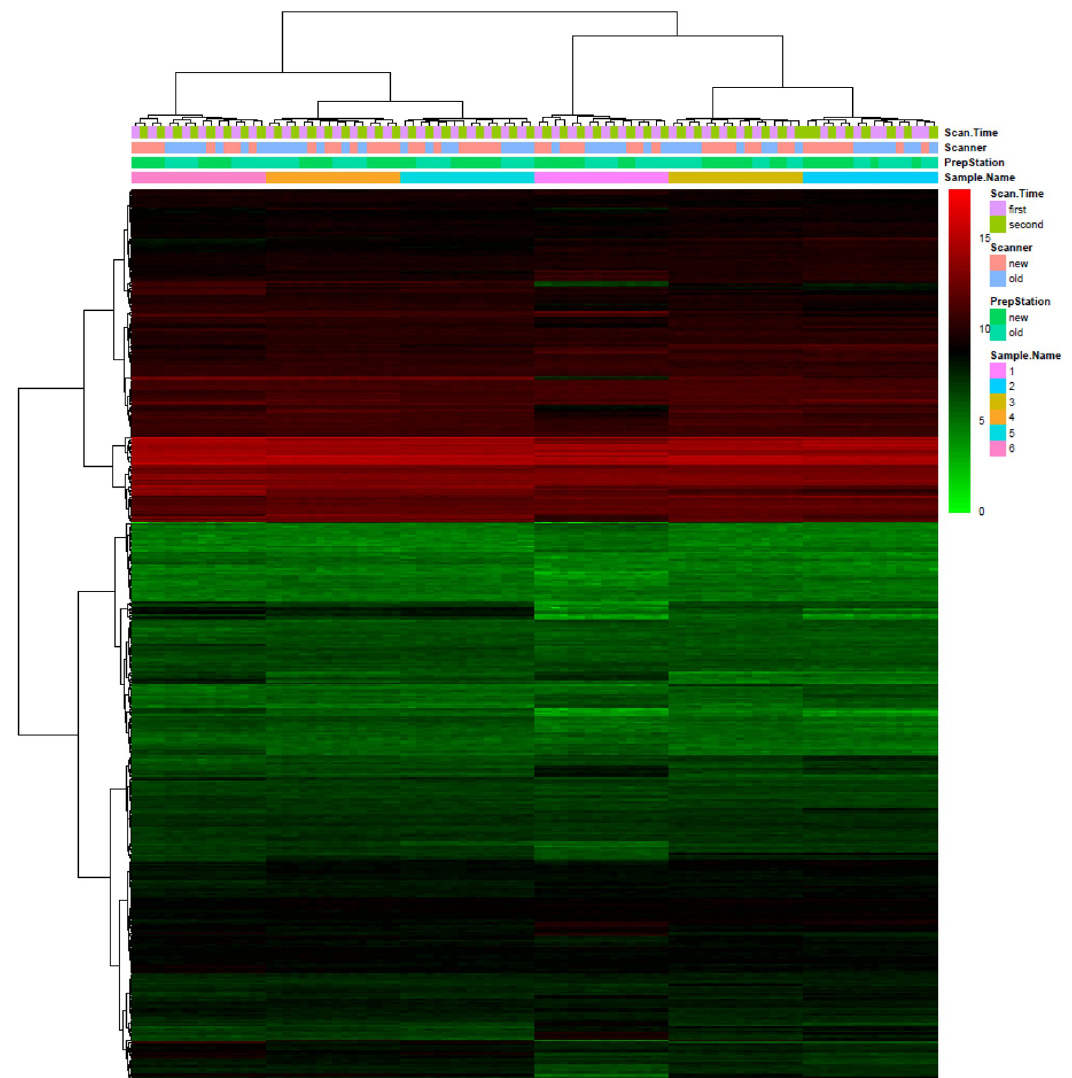
Fig 2. Heat-map of all cartridges. Signal intensity is in log2 scale, red represents higher expression levels, green represents lower expression levels, and black represents medium expression levels. Hierarchical clustering dendrograms are drawn on the heat-map for both microRNAs and biological samples. Samples and cartridges information were listed in